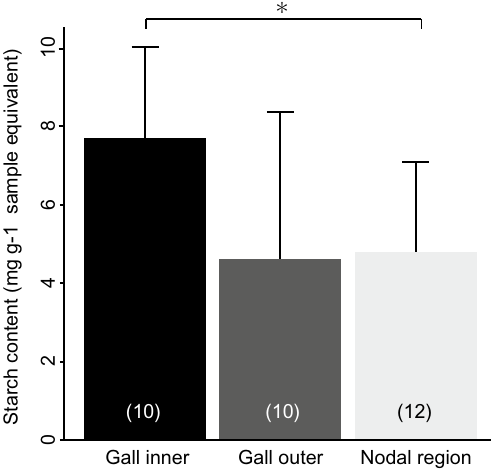
Figure 8. Starch content in Cuscuta campestris . The values are shown as means ± SD. Asterisk indicates statistically significant differences (*P < 0.05; Wilcoxon rank sum test with Bonferroni correction). Sample size is given in